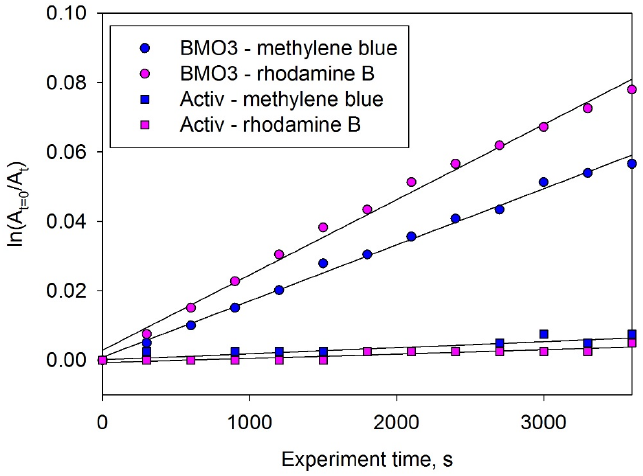
Figure 7. Degradation kinetics of in contact with sample BMO3 and Activ ® under visible light